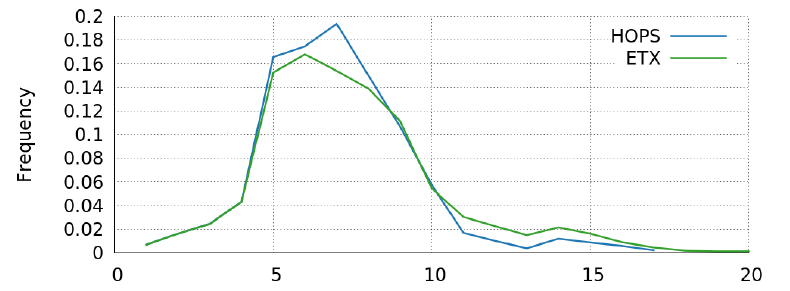
Figure 6. Frequency of path lengths based on hop count and average